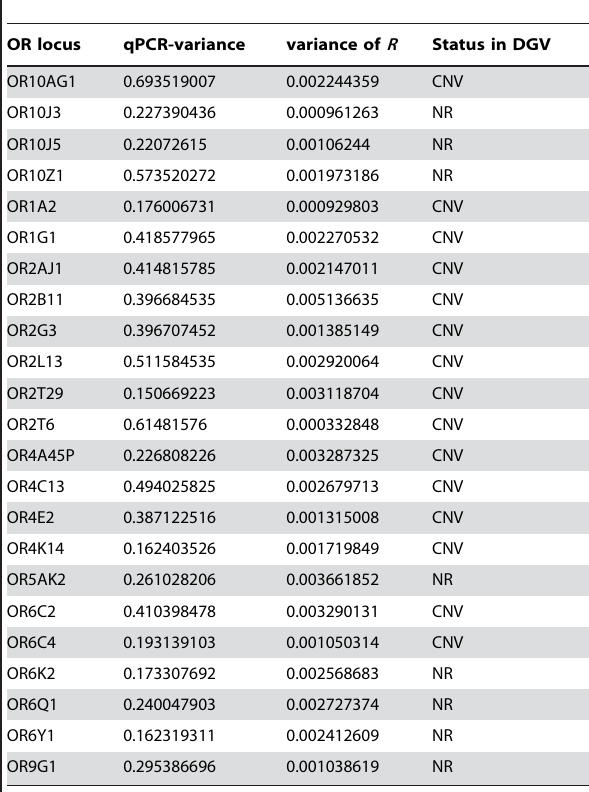
Table 2. CNVs detected in qPCR experiments that displayed little variability in microarray